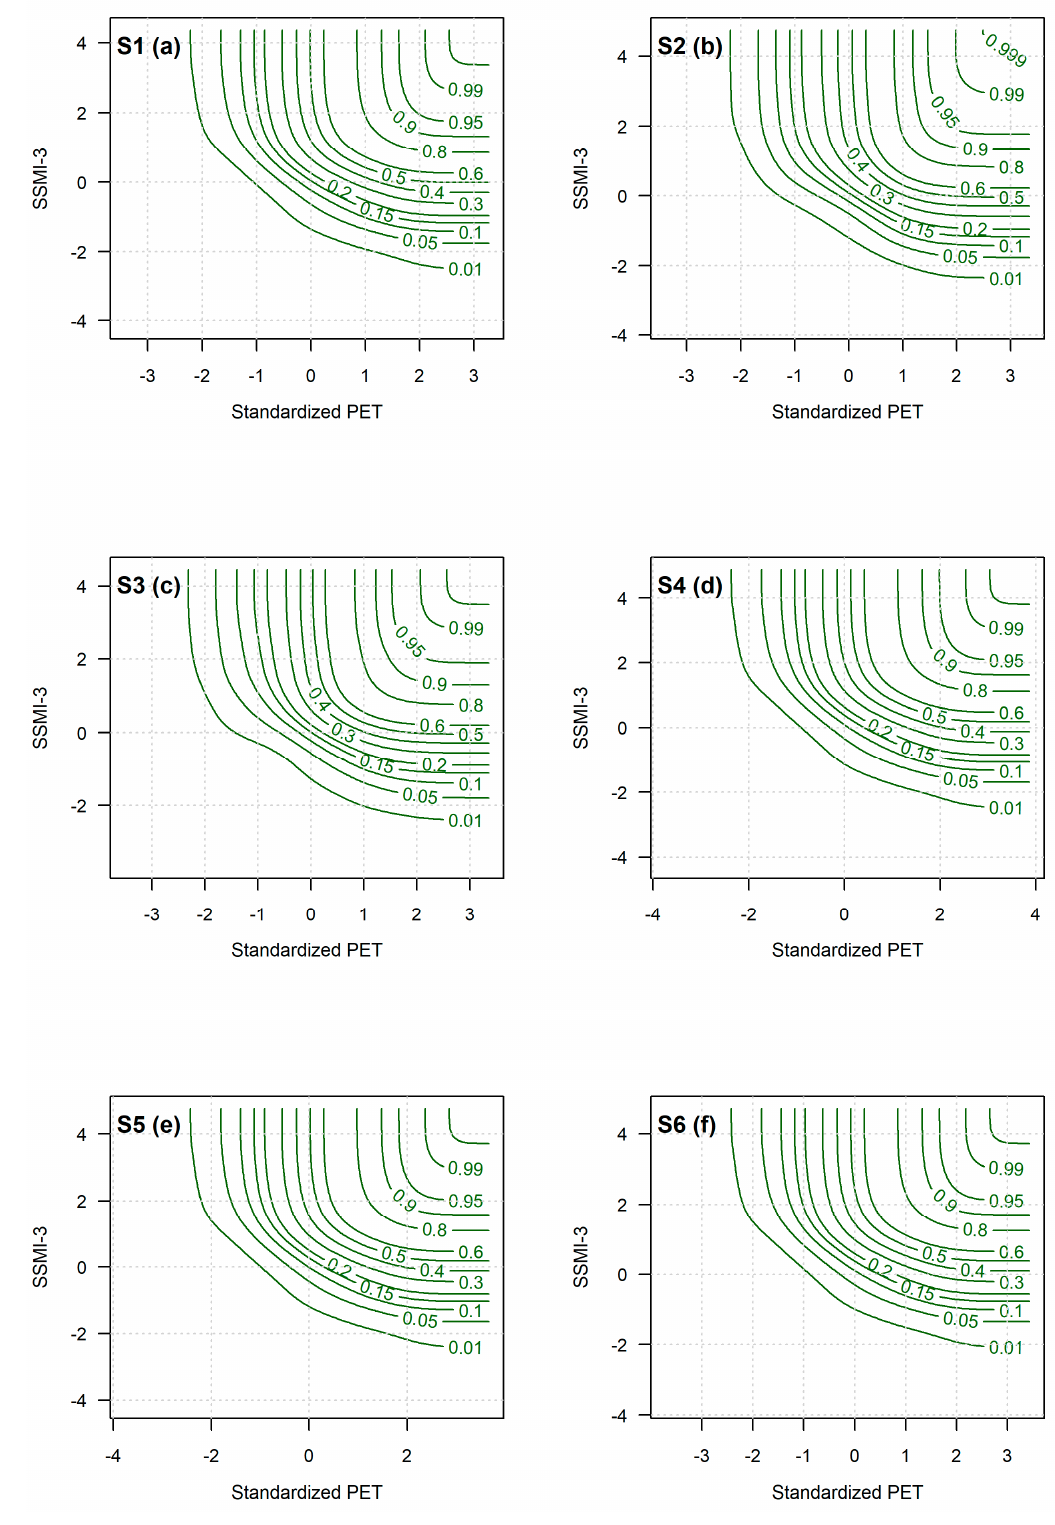
Figure 7. Bivariate distribution of SSMI3-PET for summer at six representative stations ( a – f ).